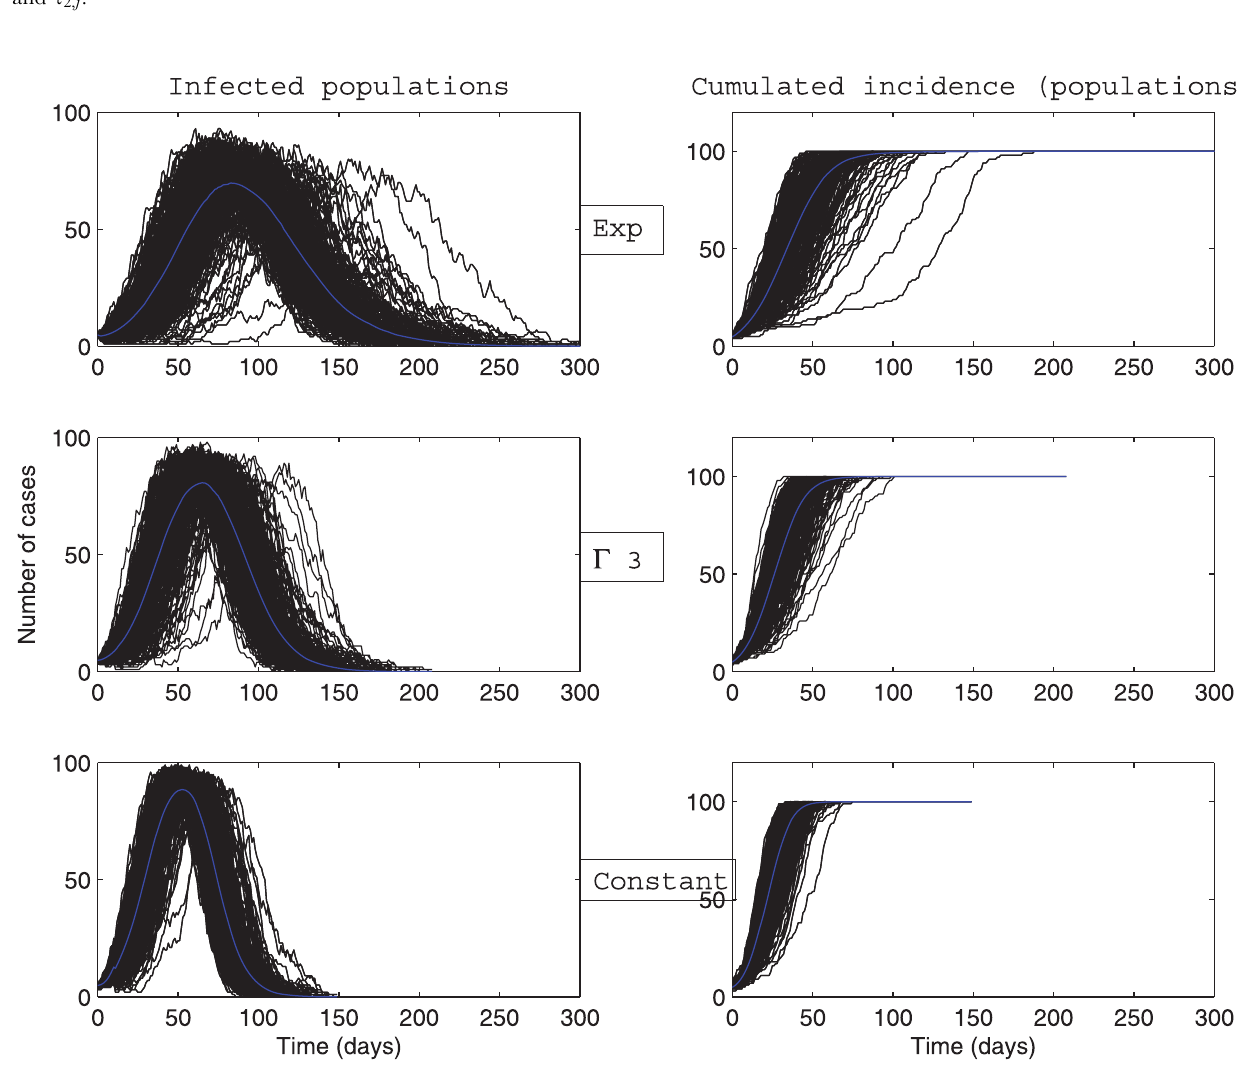
Figure 4. Dynamics of infected populations and cumulative incidence (in number of populations) described by a stochastic metapopulation model based on a completely connected network. Early extinct trajectories were not considered. The mean (blue curve) was calculated over major epidemics only (corresponding to a final attack rate greater than 5 % ). Simulations are performed using a time-continuous event-driven approach with T I * Exp( c ) (top panel), T I * C (3,3 c ) (middle panel) and T I ~ Const ~ 1 = c (bottom panel). Parameters values are given in the subsection Examples of Results.